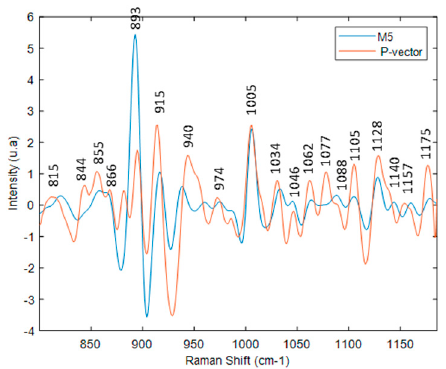
Figure 12. Superposition of the P-vector SVR model with M5 glycan.